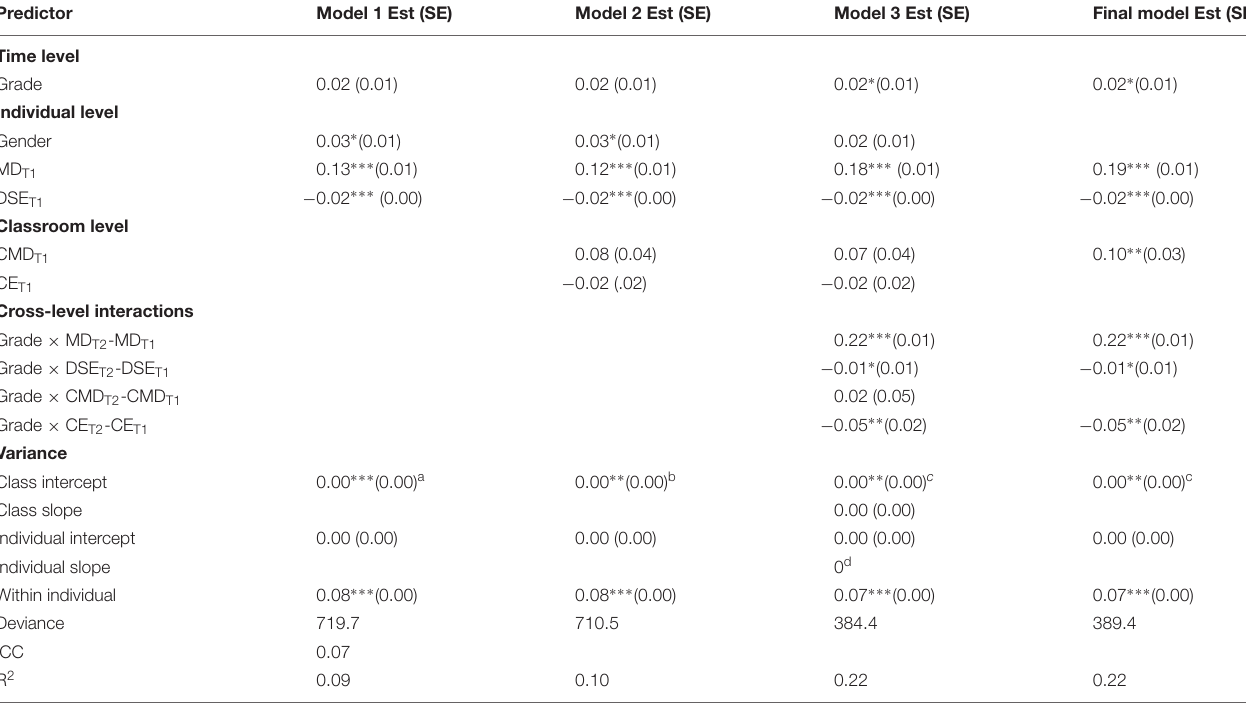
TABLE 4 | Estimates (Est) and standard errors (SE) from multilevel regression analyses of models (1), (2), and (3) with bullying as the dependent variable.